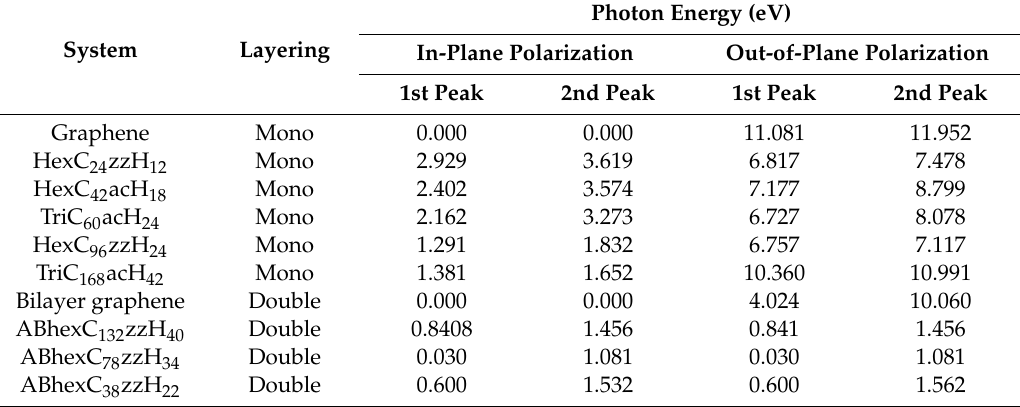
Table 3. First and second peaks of the absorption spectra of the mono and bilayer graphene and GQDs for the two polarizations.